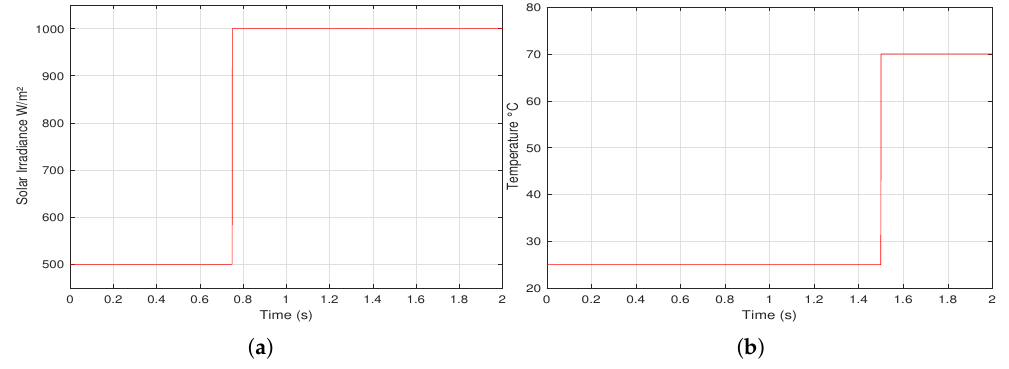
Figure 10. A proposed step variation of: ( a ) solar irradiance ( b ) cell temperature.